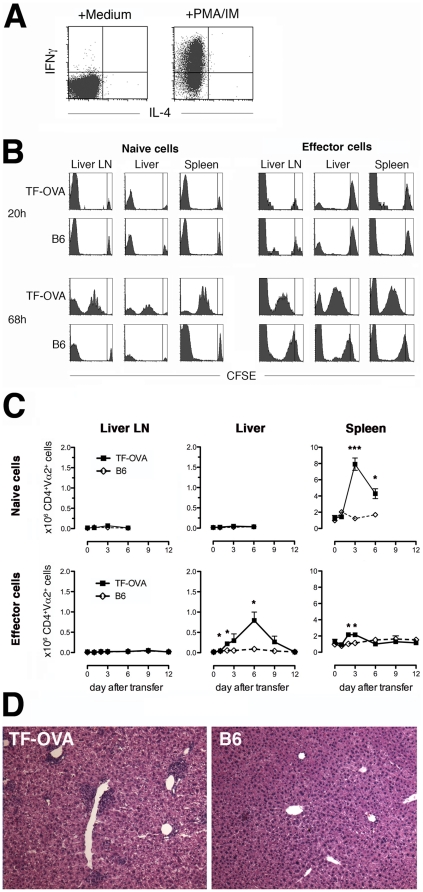
Effector CD4 T-cells accumulate in the liver of TF-OVA mice.(A) Effector OT-II T-cells with a Th1-phenotype were generated in vitro with the cognate peptide antigen in the presence of IL-12, Interferon-γ, and anti-IL-4 antibody. After 6 days in culture, cells were restimulated with PMA/ionomycin and stained for Interferon-γ and IL-4. (B) Four million CFSE-labeled naïve or effector OT-II T-cells were transferred into TF-OVA or B6 control mice. Non-parenchymal cells from the indicated organs were isolated after 20 or 68 hours, and analyzed for the presence of proliferating OT-II T-cells by CFSE dilution. All plots depict data gated on CD4+Vα2+ cells. Events to the right of the vertical line represent the undivided population. Events at the far left of the plot represent unlabeled endogenous cells. Representative results from n = 4–6 mice in each group are shown. (C) Cells from the indicated organs were isolated at the indicated days after transfer of 4 million naïve or effector OT-II T-cells, and numbers of CD4+Vα2+ cells were enumerated. Data shown are derived from n = 3–6 mice per group at each time point. Note the different scales for spleen and liver/liver lymph node (mean ± SEM; * p<0.05, *** p<0.001 by Student's t-test). (D) Liver sections from TF-OVA and B6 mice were stained with H&E 6 days after transfer of 4 million effector OT-II T-cells. Representative images from n = 6 mice per group (magnification 100x) are depicted.